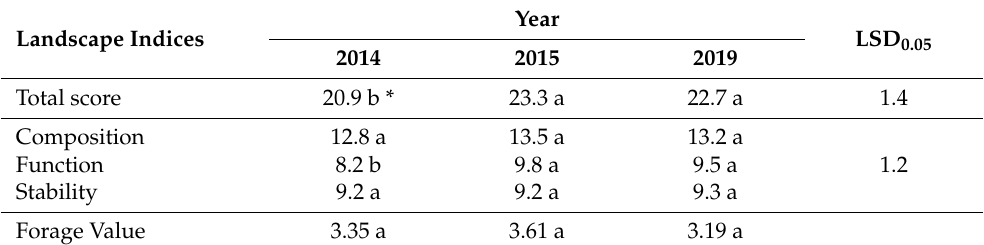
Table 8. Effects of years (across sites) on the indices of landscape composition, function, stability, and forage value.